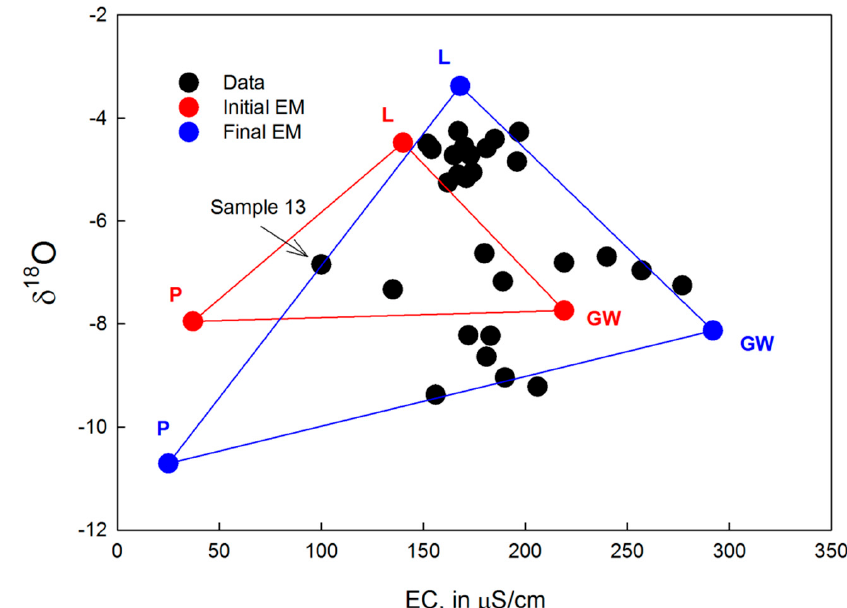
Figure 8. Initial and final end-member concentrations for precipitation (P), groundwater (GW), and lake (L) using the dual-tracer approach. Sample 13 is from the eastern shoreline. Data are from February 2016. Table 2. Initial and calculated end-member concentrations in precipitation (P), groundwater (GW), and lake water (L) based on mixing analysis using EC + δ 18 O, δ 18 O only, and EC only. EC ( µ S /